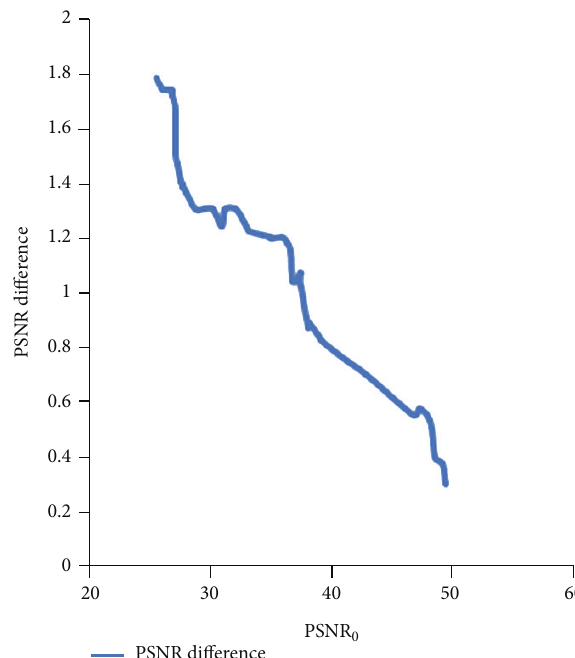
Figure 16: Trend of PSNR difference with respect to PSNR 0 ( 𝜌 = 0.006944 ).